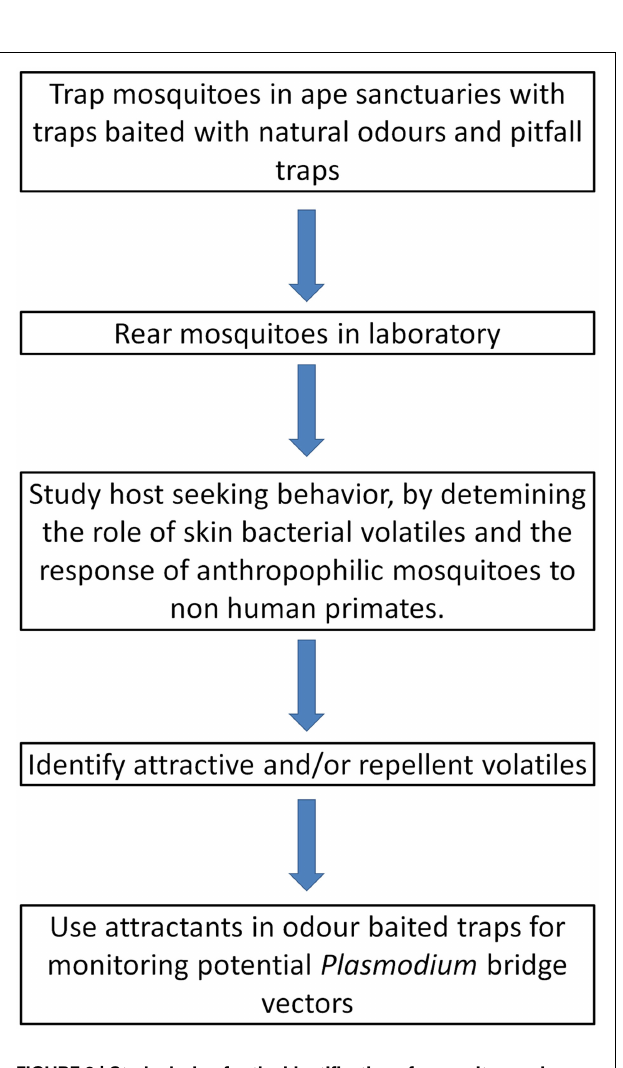
FIGURE 3 | Study design for the identification of mosquito species that may act as bridge vectors of Plasmodium